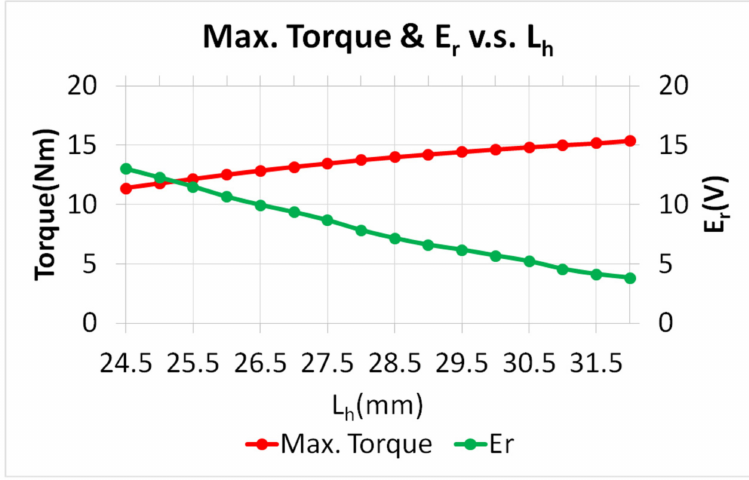
Figure 16. Maximum torque and E r of the target type rotor versus L h